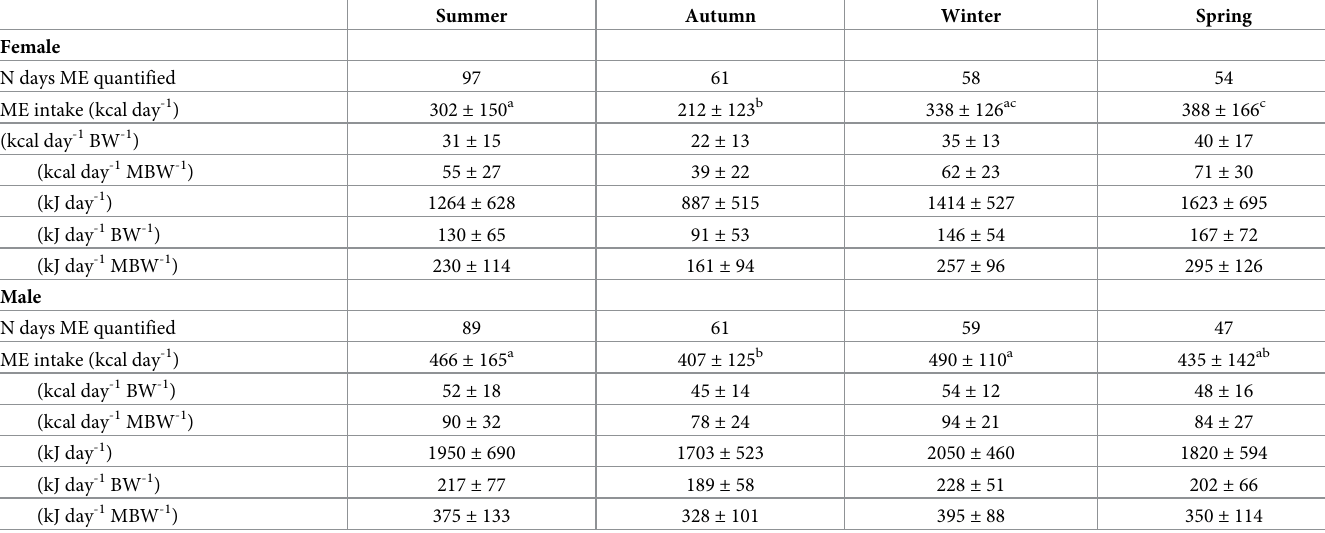
Mean values reported with ± standard deviations. Shared superscripts within a row indicate that means were not significantly different. ME intake = metabolizable energy intake and is reported in multiple formats; BW = body weight in kg; MBW = metabolic body weight in kg and was calculated using the formula: MBW = BW 0.75 . Female and male ME intake values were not compared to each